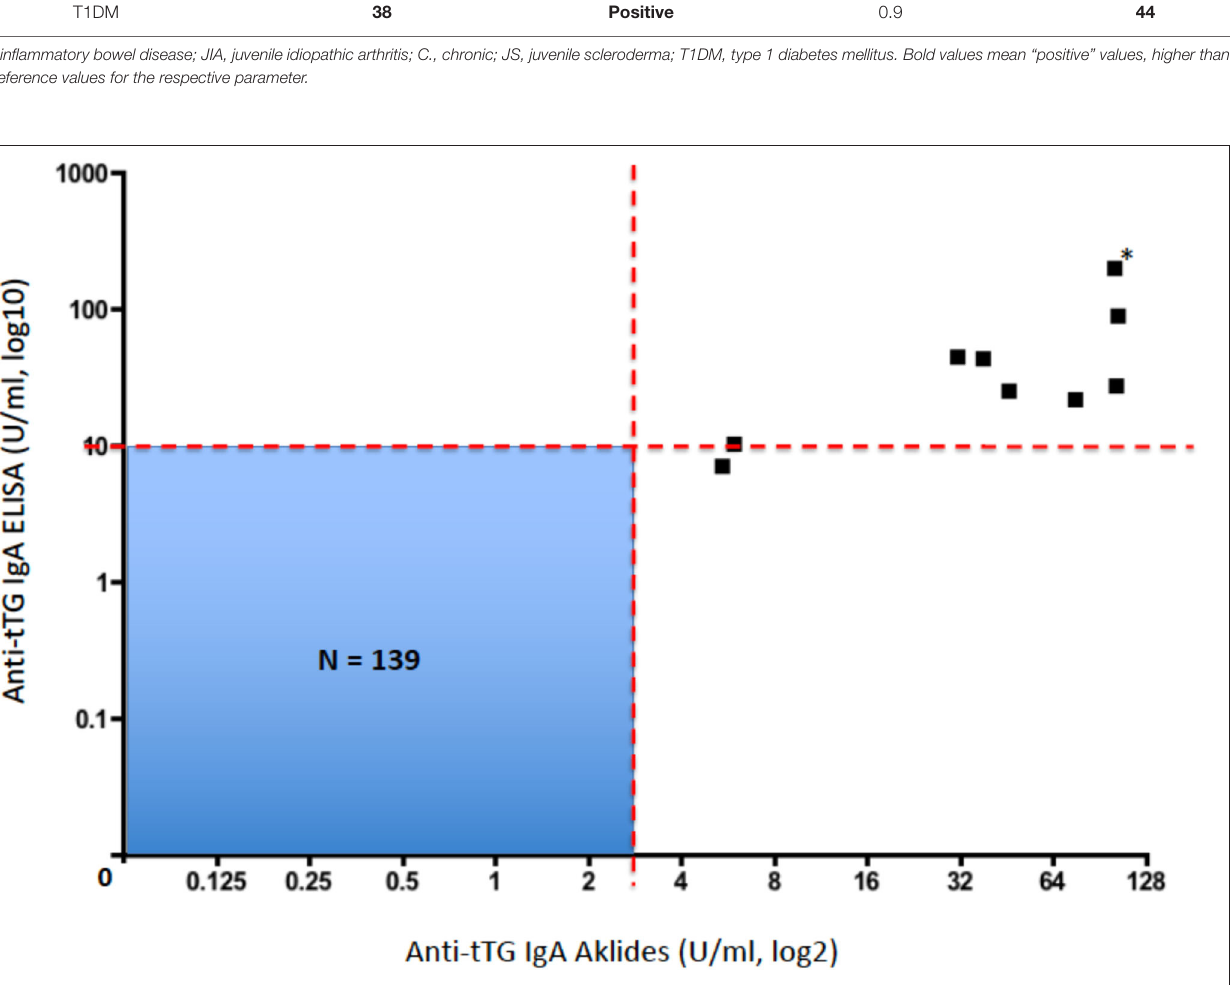
Frontiers in Medicine |